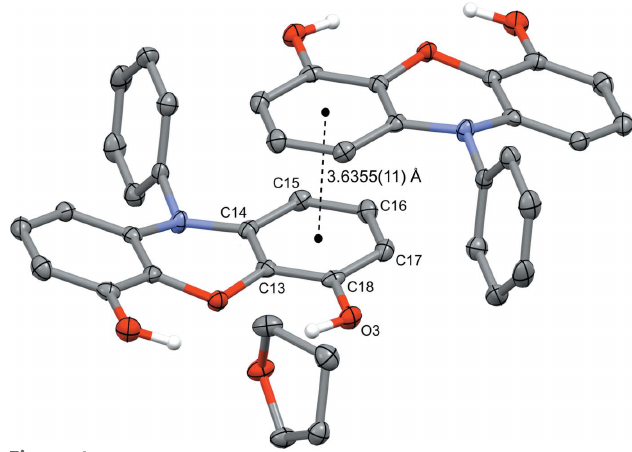
Figure 4 Solid-state structure of 10-phenyl-10 H -phenoxazine-4,6-diol with the major THF component (50% ellipsoids). An additional inversion-related (1 (cid:5) x , 1 (cid:5) y , 1 (cid:5) z ) molecule is included, showing the (cid:2) – (cid:2) stacking distance of 3.6355 (11) A˚ .